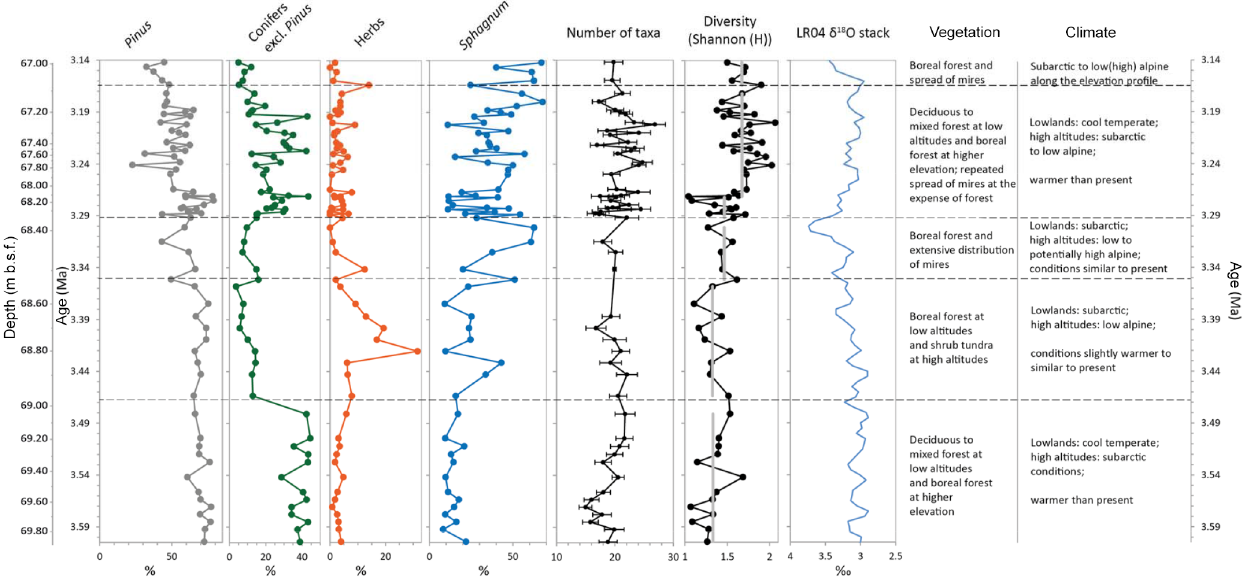
Figure 7. Summary diagram illustrating percentage changes in the main taxa or taxa groups, diversity based on the Shannon index, numbers of taxa rarefied at 300 individuals, the global benthic LR04 oxygen isotope stack (Lisiecki and Raymo, 2005) and description of the main vegetation configurations and climatic conditions. The vertical grey lines in the diversity graphs correspond to the average value across the interval. The dashed horizontal lines correspond to the main pollen zones shown in Fig.